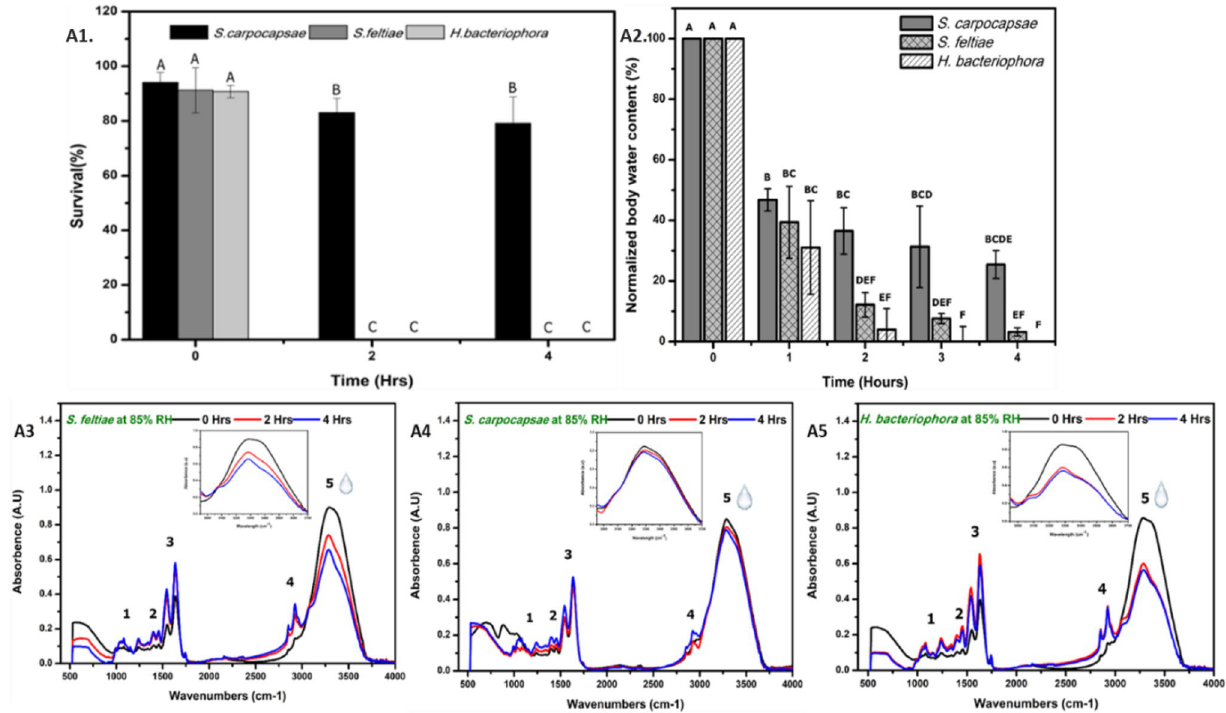
Figure 1. EPNs species ( S. carpocapsae (SC), S. feltiae (SF), H. bacteriophora (HB)) rapidly desiccated at 85%RH. Survival (%) ( A1 ) and gravimetric rate of water loss ( A2 ) at 85%RH. ( A3 – A5 ) Comparison of FTIR spectra depicting the water peak of rapidly desiccated S. feltiae, S. carpocapsa e, H. bacteriophora at 85%RH for 0, 2 and 4 h. Inlet in each figure represents the peak of OH (water)/NH bonds. The numbers inside the spectra represents the bands that were strongly affected due to different humidities (see Table S1 for assignment of functional